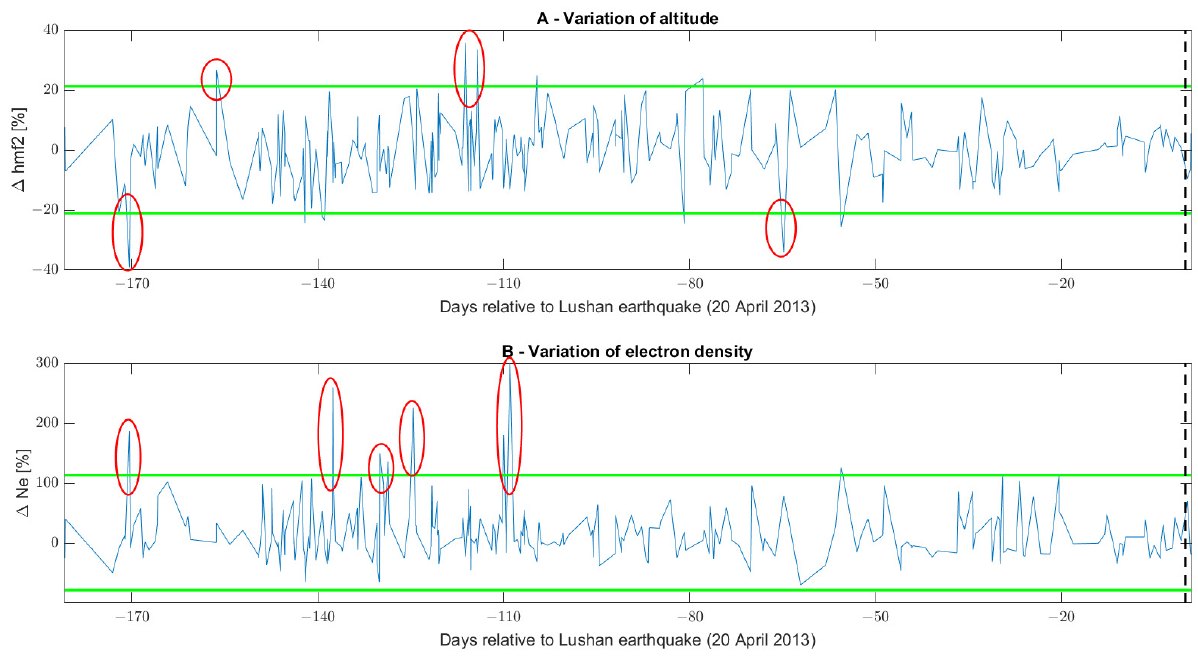
Figure 21. Variation in the altitude ( A ) and electron density value ( B ) of the ionospheric peak F2 in the six months preceding the Mw = 6.7 Lushan 2013 earthquake. The estimation of the two parameters comes from the ionospheric profiles measured by the Formosat3 satellite, and the variations are relative to the background area. Two green lines show the mean plus or minus two standard deviations of the same values. Table 1. Anomalous values of the F2 ionospheric peak as extracted from the time series shown in Figure 21. In the first rows, the anomalous altitude days of the F2 peak are presented, and in the following rows, the anomalous days for an increase in electron density in the F2 peak are